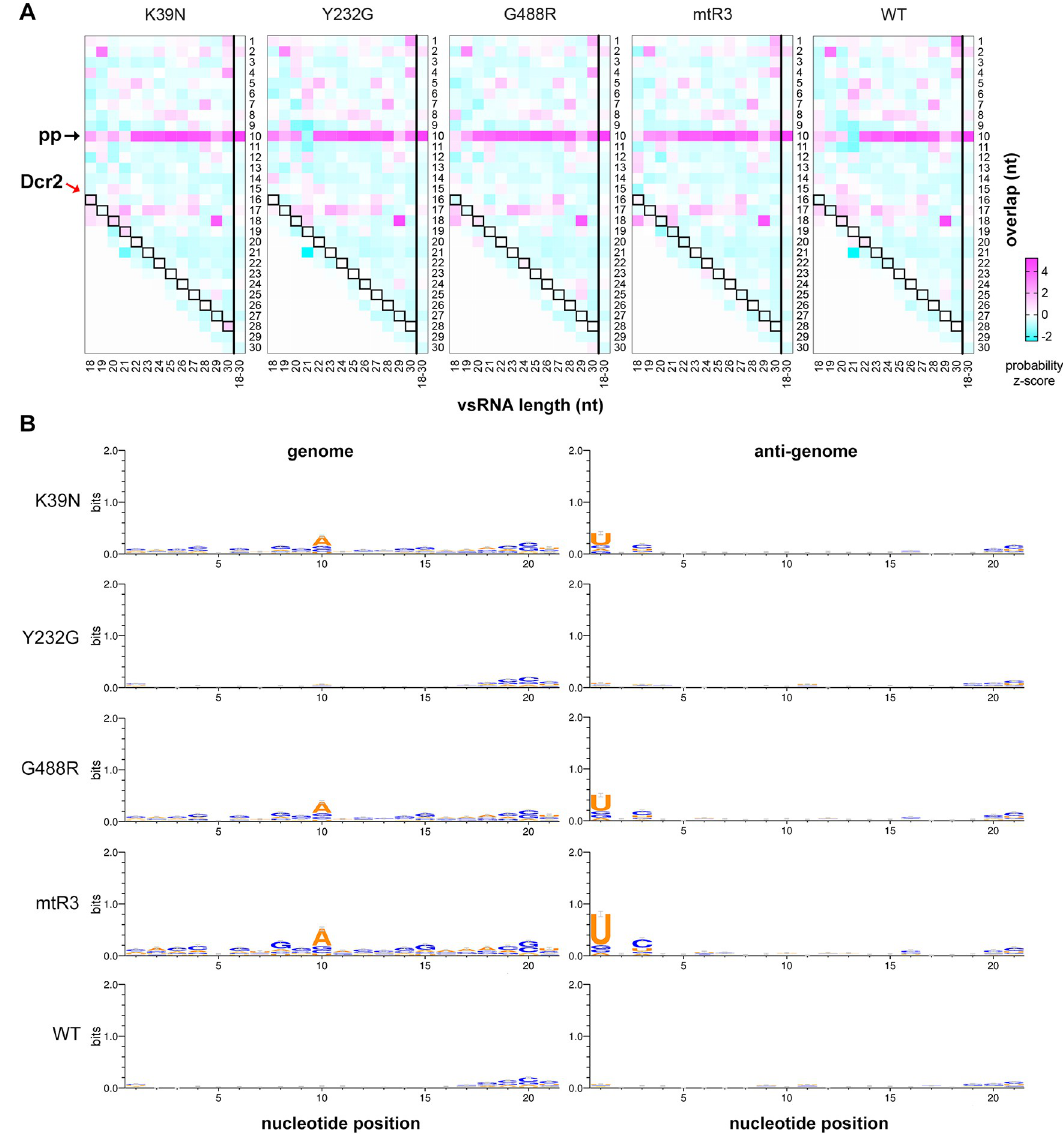
Fig 5. Characterising 21 nt vsiRNAs with vpiRNA signature: vsi-piRNAs. (A) Heat maps showing mean overlap probabilities of z-scores of 18–30 nt SFV-derived vsRNAs from AF319 transiently expressing mutant or WT Dcr2 from n = 2 independent repeats. vsRNA lengths are shown horizontally, and the number of nucleotide overlaps listed vertically. Red arrow labelled Dcr2 indicates expected 2 nt overlap from dsRNA cleavage with cells boxed in black. Black arrow labeled pp (ping-pong) shows expected 10 nt overlap from potential ping-pong amplification. (B) Representative sequence logos of n = 2 independent repeats (other replicate in S5 Fig) of 21 nt vsRNAs mapping to the genome (left panel) or anti-genome (right panel) of SFV from AF319 transiently expressing mutant or WT Dcr2. Overall height of the stack indicates conservation presented as bits, with the height of each symbol reflecting the relative frequency of the corresponding nucleotide at a given position. Error bars indicate an approximate Bayesian 95% credible